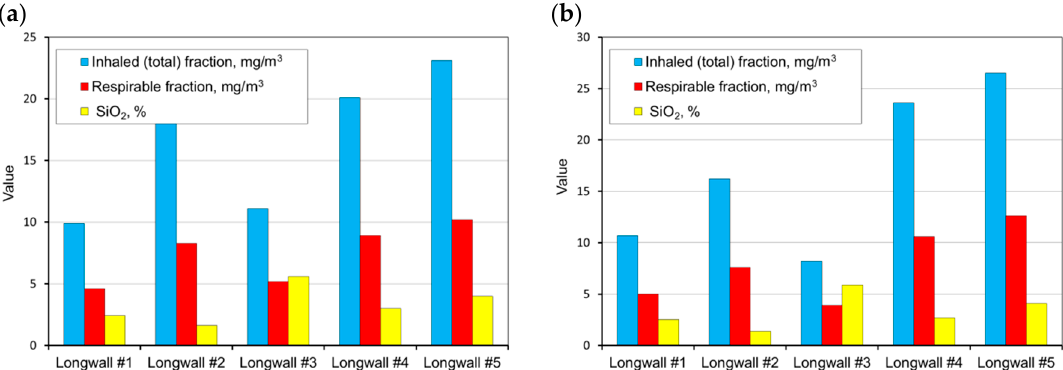
Figure 6. The measurement results for the dust levels in the positions of the assistant cutter-loader man ( a ) and the miner working at the junction of the longwall with the tailgate (air outlet) ( b ) (workplaces 2 and 3).